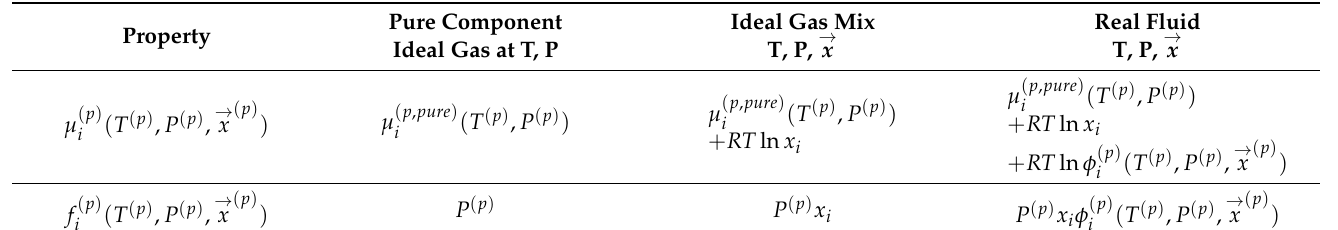
Table 1. Residual thermodynamic integration scheme for chemical potential and fugacity. Property